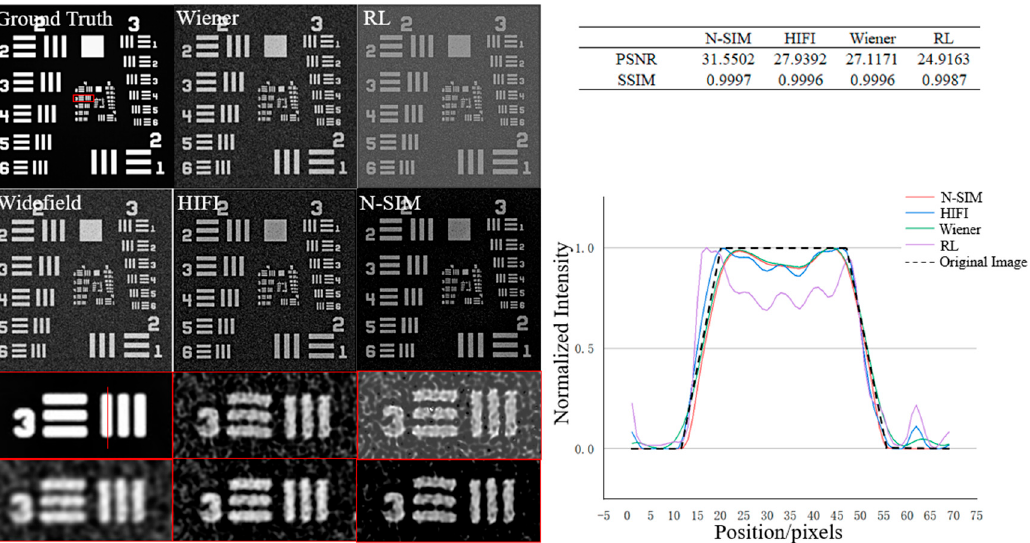
Figure 4. Reconstruction results of modulated resolution board using Wiener-SIM, RL-SIM, HIFI-SIM, N-SIM respectively, and gray value analysis results on the red line. The images below are magnified images corresponding to the red box area above.